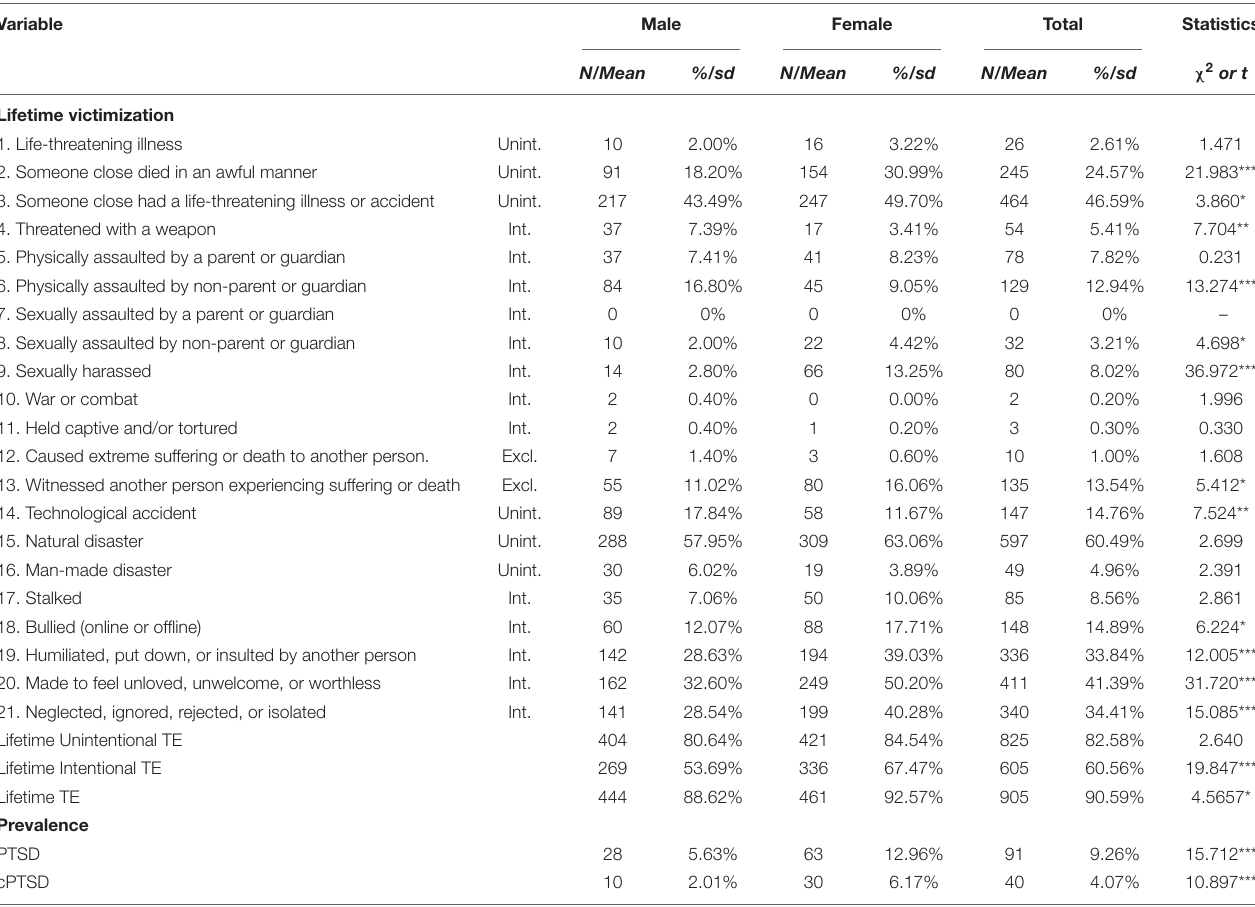
TABLE 2 | Lifetime traumatic experiences, psychopathology and gender differences in the sample.